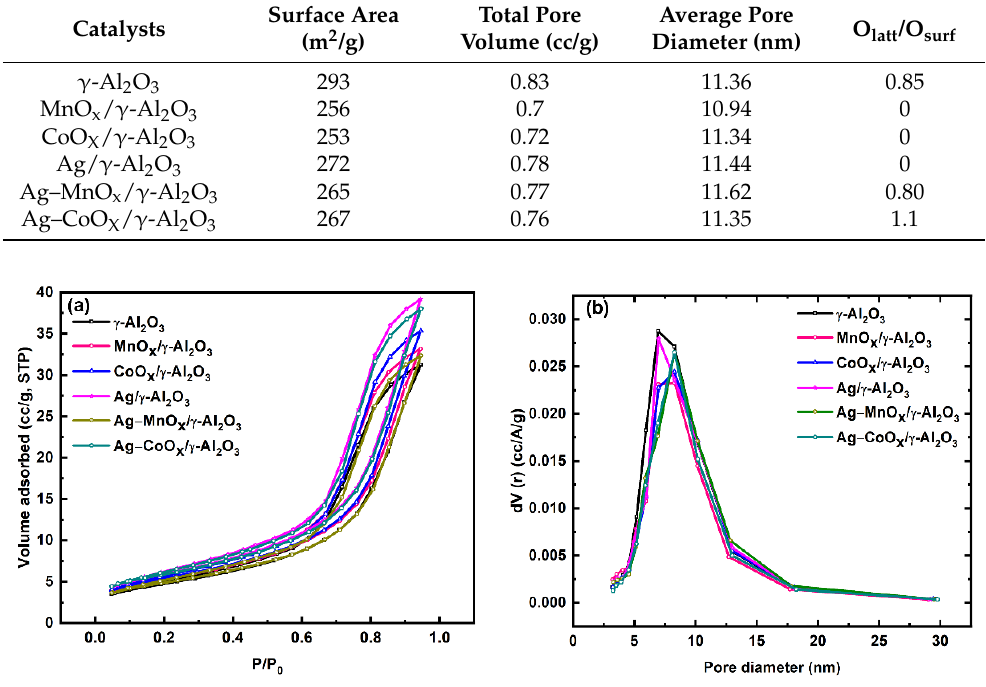
Figure 2. ( a ) N 2 adsorption-desorption isotherms. ( b ) Pore size distribution of fresh catalysts .